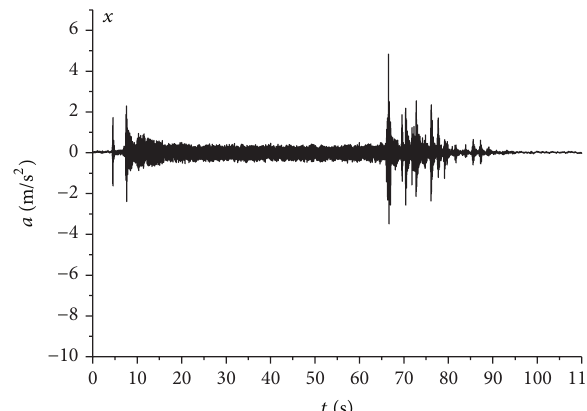
Figure 5: Acceleration in 𝑥 .